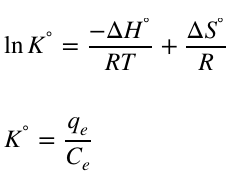
Fig. 7 Kinetic studies for the adsorption of MB dye onto nZVAl: a Pseudo-first-order model (linear form), b Pseudo-second-order model (linear form), c Intraparticle diffusion model (linear